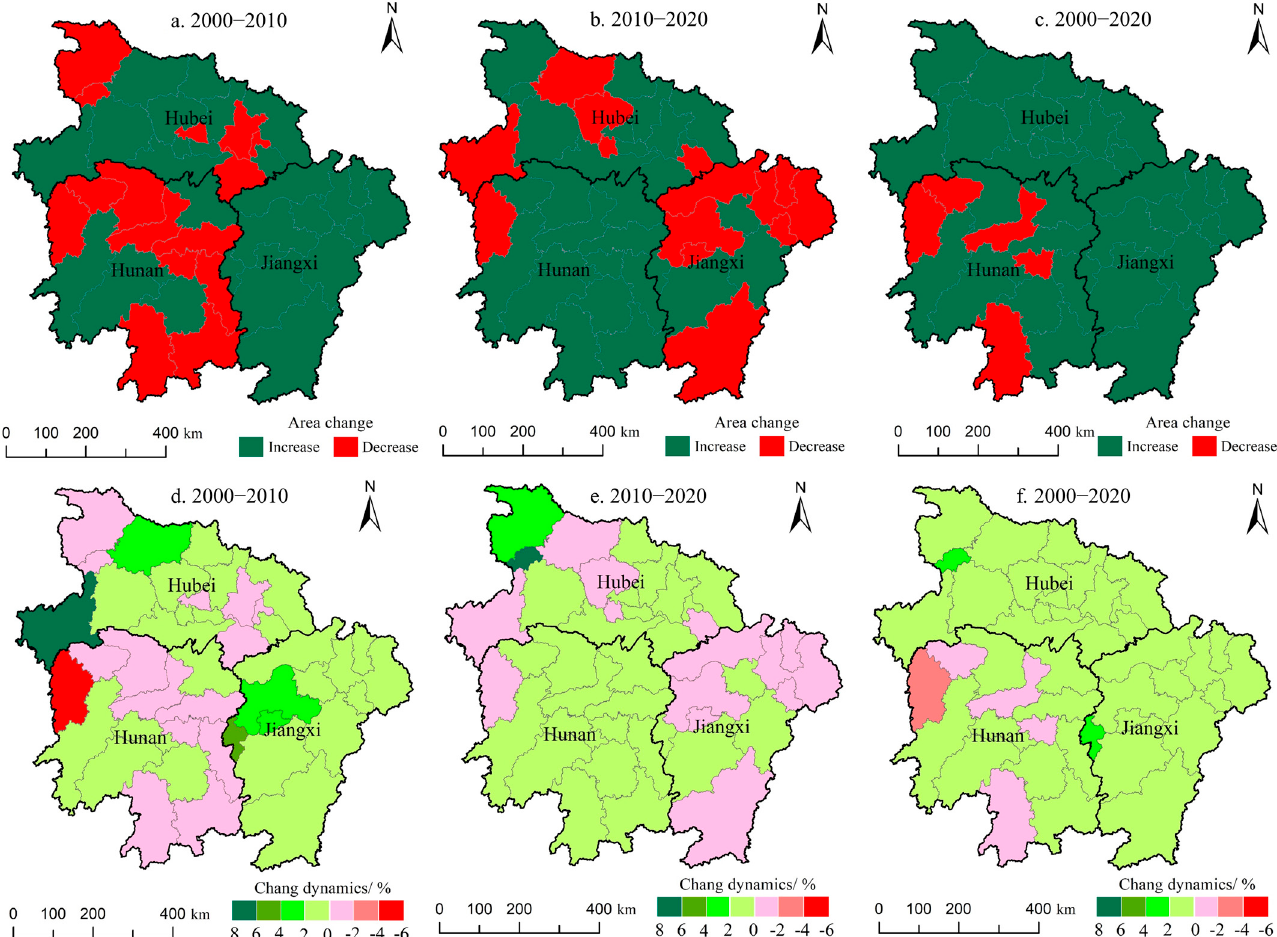
Figure 4. Distribution of RRL area change in 42 cities in the MRYR. ( a – c ) Change in the RRL area during 2000 − 2010, 2010 − 2020, and 2000 − 2020, respectively. ( d – f ) Change dynamics of the RRL area during 2000 − 2010, 2010 − 2020, and 2000 − 2020, respectively. Table 4. Statistics on the RRL area change in 42 cities in the MRYR.